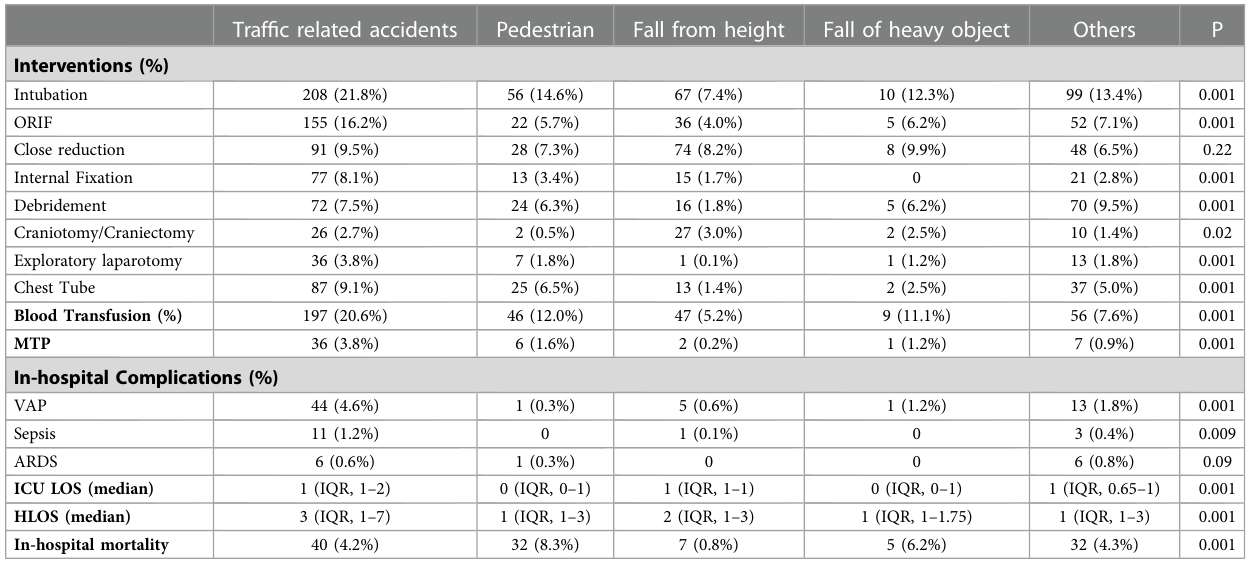
TABLE 4 Interventions, complications, and outcomes of pediatric traumatic injuries by mechanism of injury.